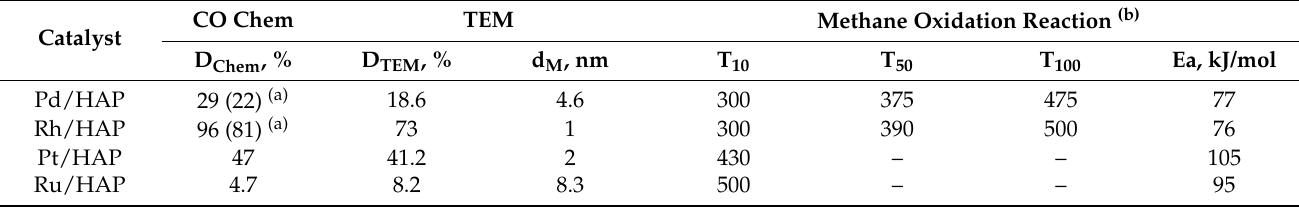
(a) Data corresponding to the catalysts submitted to three cycles of the reaction (Figure 9). (b) Data extracted from Figure 6.